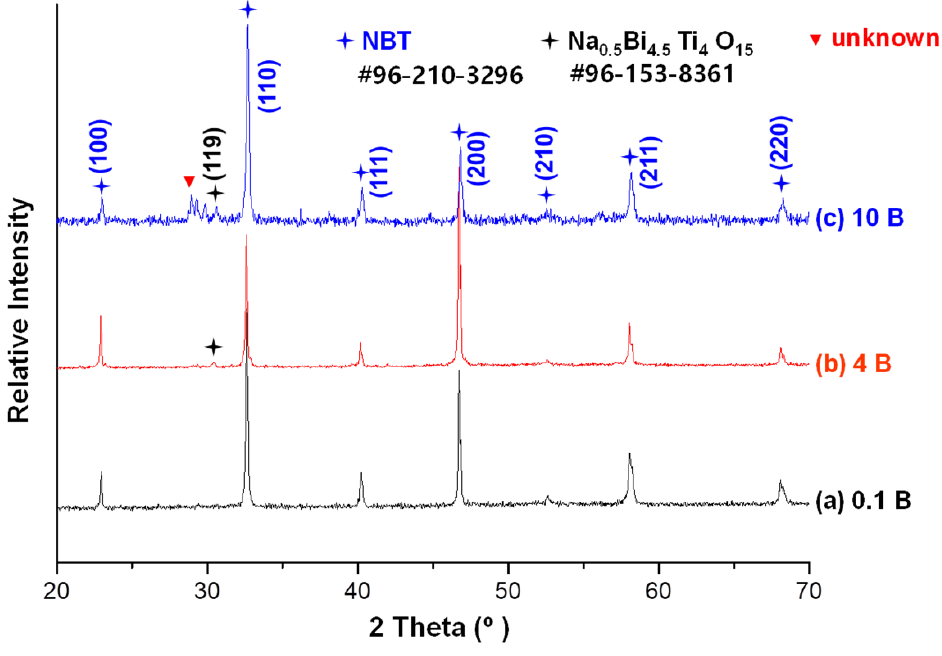
Figure 1. X-ray diffraction (XRD) patterns of Bi 2 O 3 -excess 0.95Na 0.5 Bi 0.5 TiO 3 -0.05BaTiO 3 (NBT–5BT) sintered at 1200 °C for 4 h in air: ( a ) 0.1 mol% Bi 2 O 3 -excess NBT–5BT; ( b ) 4 mol% Bi 2 O 3 -excess NBT–5BT; ( c ) 10 mol% Bi 2 O 3 -excess NBT–5BT. The star indicates the 2nd phase.